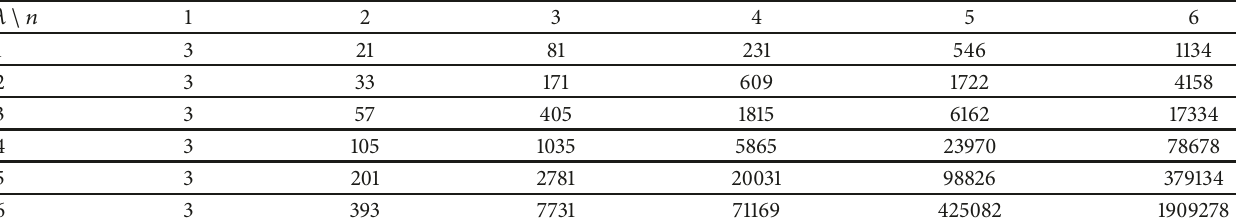
Table 1: Modified Wiener index of 𝑇𝑂𝑋 .